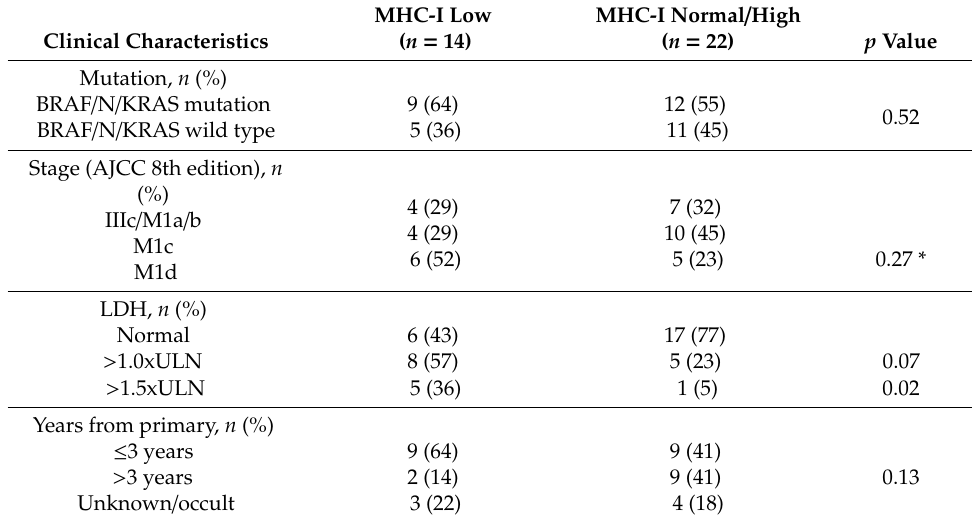
immune subsets analyzed (Supplementary Figure S3a), total T-cells expressing the αβ T cell receptor (TCR αβ ) and CD8 T-cells were higher in MHC-I normal/high compared to MHC-I low tumors (Figure 3b, Supplementary Figure S3b), while myeloid cells (macrophages/monocytes and myeloid